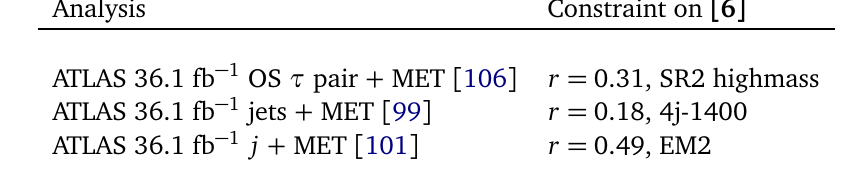
Table 8: Summary of constraints on benchmark point [ 6 ] from the most sensitive 13 TeV searches implemented in C HECK MATE at the LHC. The SR2 highmass and EM2 regions have been described in Table 6. The 4j-1400 region imposes a hard cut on missing E , requires at least four hard jets with invariant mass larger than 1.4 T